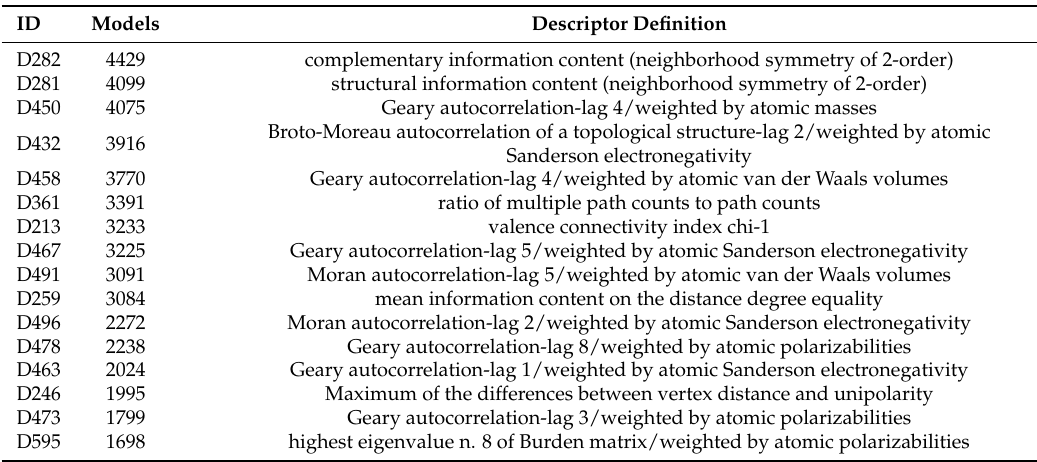
Table 2. Informative descriptors identified from the cross validations.